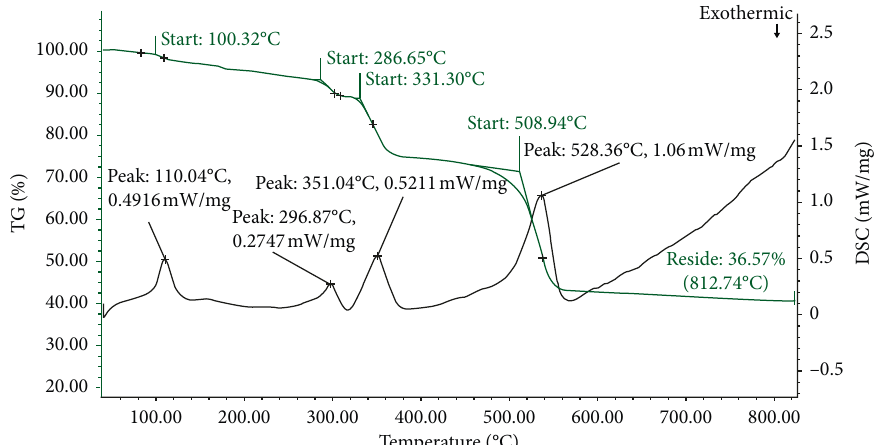
Figure 1: TGA curve of La-ZIF-8.